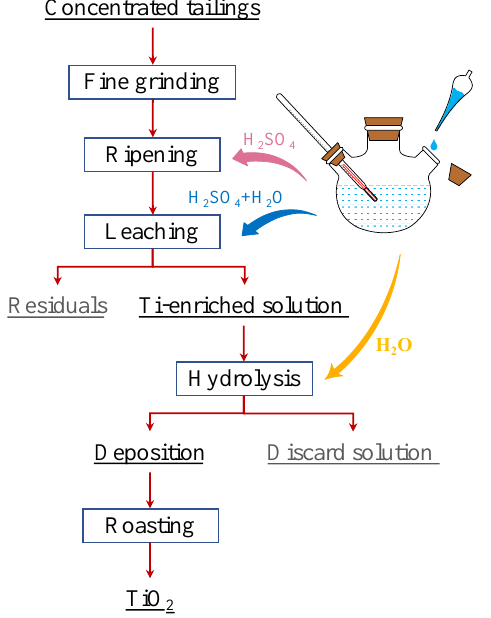
Figure 1. Schematic diagram of experimental procedure and apparatus.